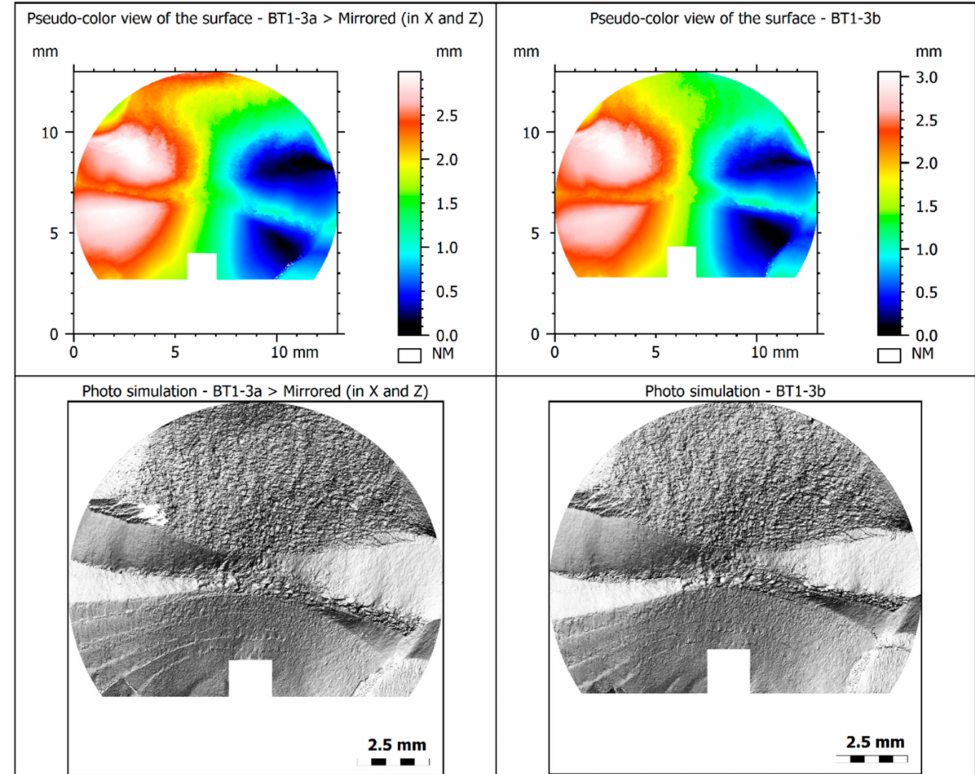
Figure 7. Both sides of fracture surfaces of the specimen (BT1-3). The figure on the left-hand side has been mirrored with respect to the x-axis.